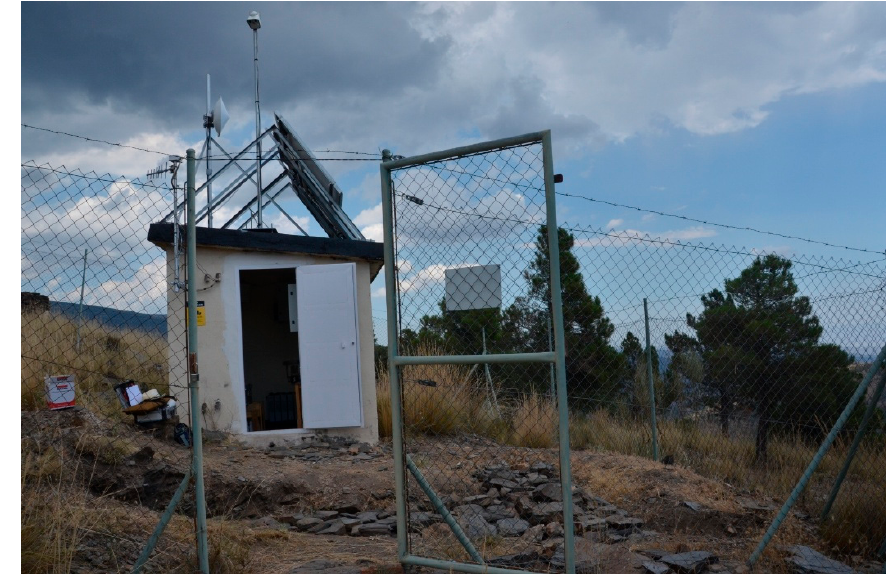
Figure 2. Calar Alto Extremely Low Frequency (ELF) Station (Spain).